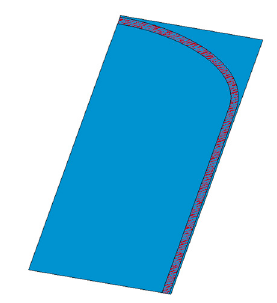
Figure 3. Two-dimensional 1 / 4 model of the containment vessel. The blue mesh is the air and the red mesh is the explosive containment vessel.